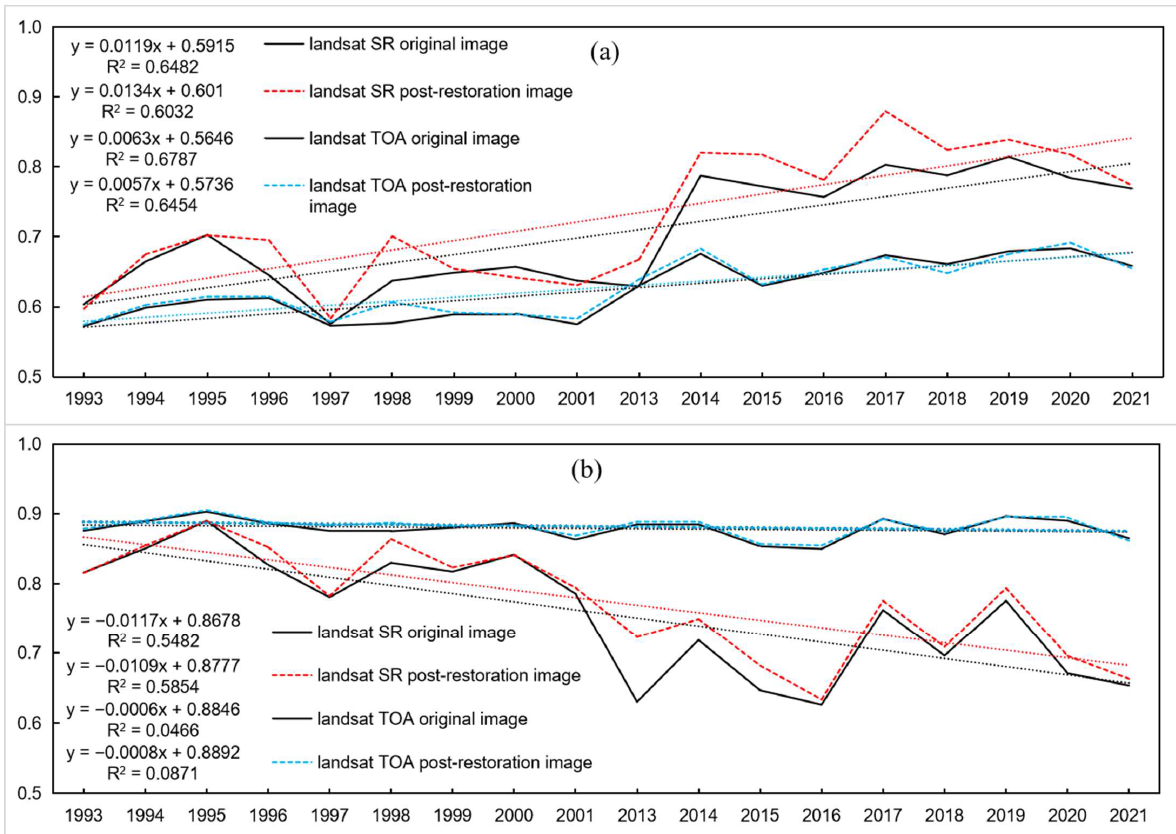
Figure 3. Time-series analysis. ( a ) NDWI image; ( b ) MNDWI image.